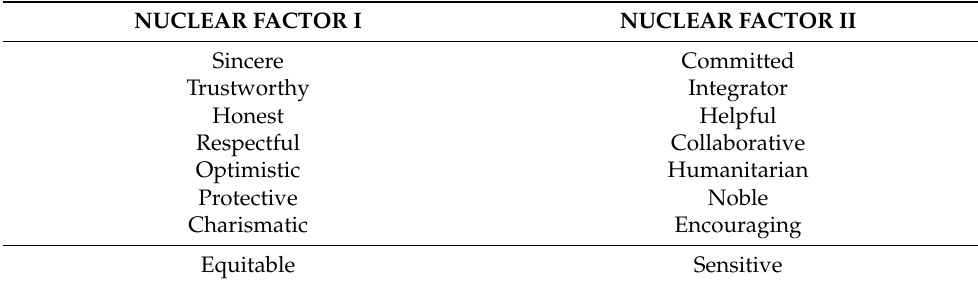
Table 6. Nuclear factors of the structuring of the